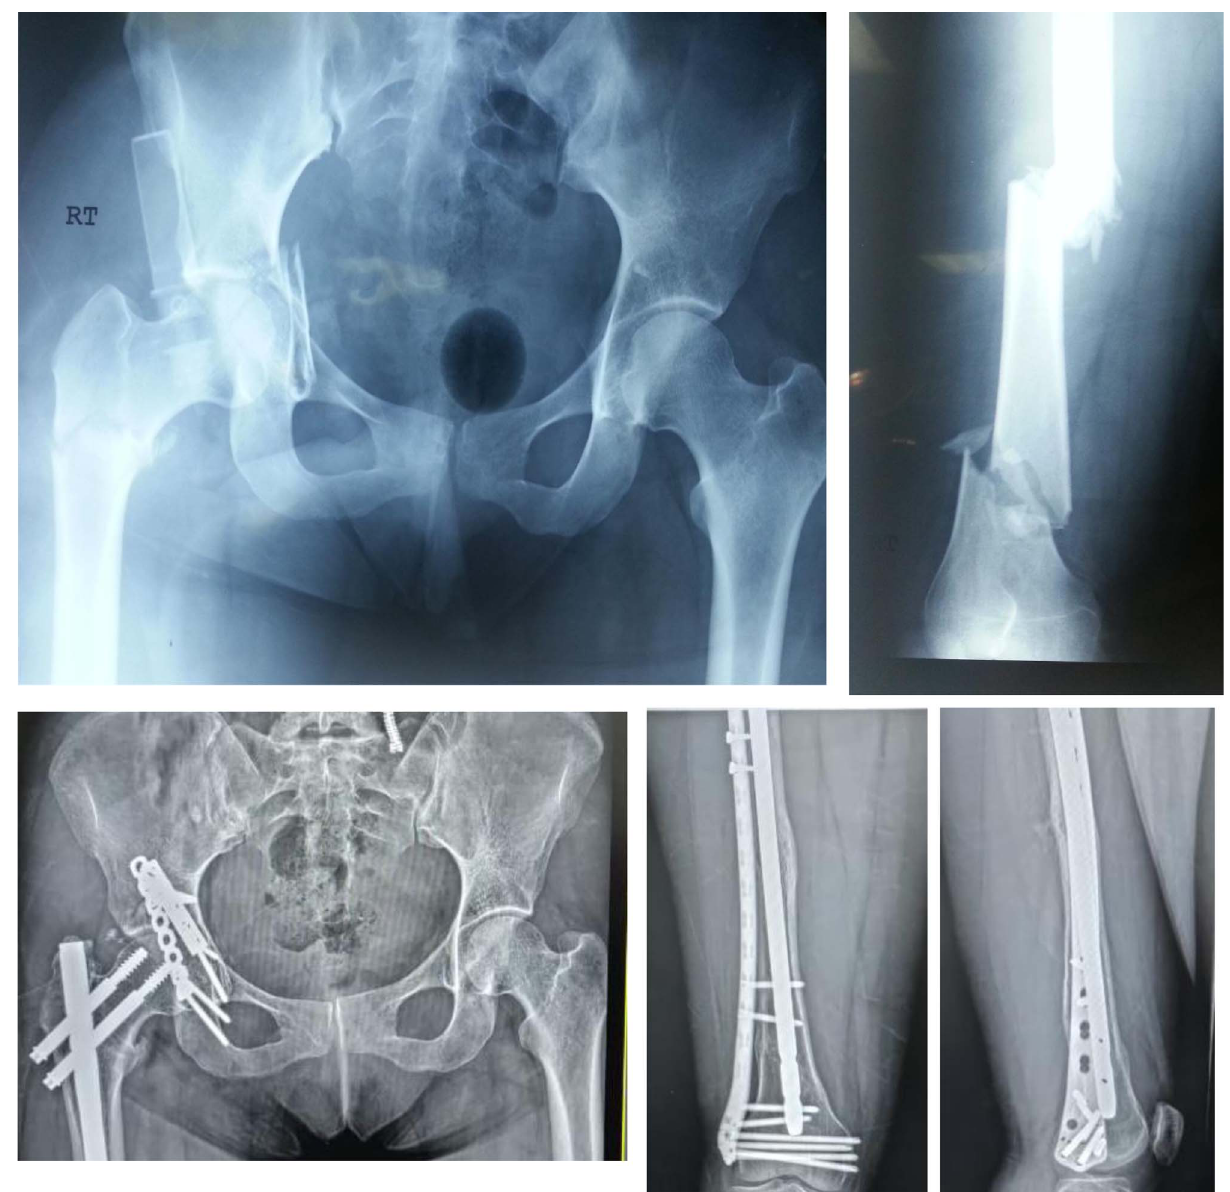
Figure 3. Top row: Preoperative X-rays for an ipsilateral acetabular and segmental femoral fracture, treated with fi xation of acetabulum through posterior approach, and femoral nailing followed by plate augmentation for nonunion of midshaft fracture. Bottom row: 6 year follow- up